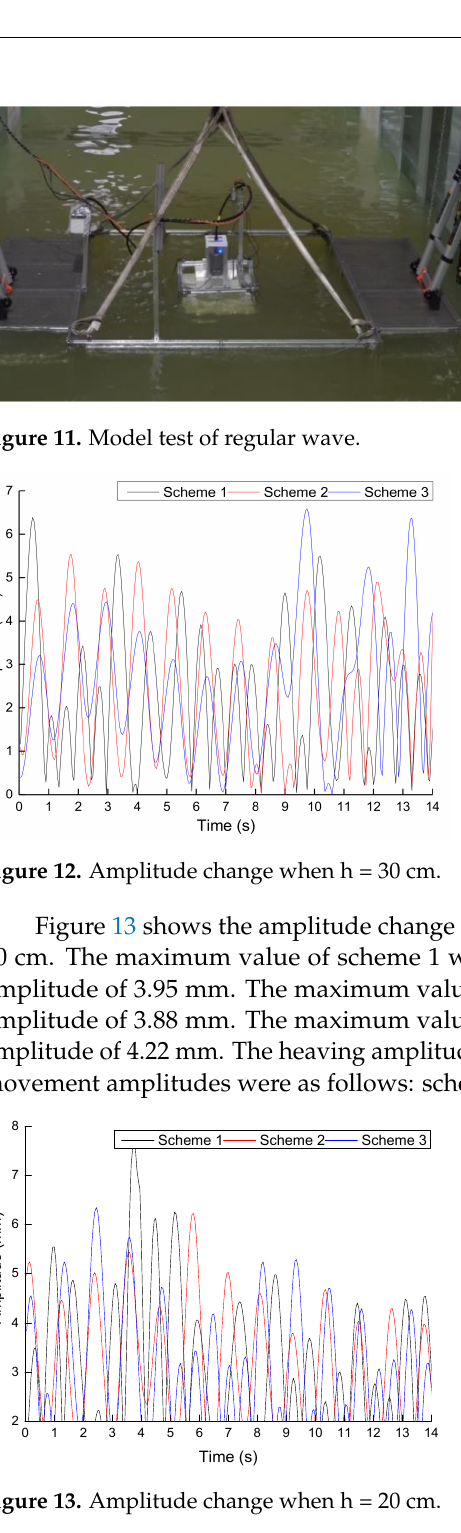
Figure 14. Amplitude change when h = 10 cm. 0 1 2 3 4 5 6 7 8 9 10 11 12 13 148 91011121314 1516 1718 A m p li t ude ( mm ) Time (s) Scheme 1 Scheme 3 Scheme 4 Figure 15. Amplitude change when h =5 cm and no heaving plate is installed. Figure 16 shows the change in the average amplitude of the heaving plate as the in- stallation distance changes. The average amplitudes of the three different shapes of heav- ing plates decreased with an increasing installation distance. When the distance was be- tween 10 mm and 20 mm, the average amplitude changed significantly, and when the distance was between 20 mm and 30 mm, the average amplitude changed relatively little. Therefore, the installation distance under this regular wave condition should be more than 20 mm. When the areas were the same, the average amplitude of the circular heaving plate was greater than that of the square heaving plate and chamber heaving plate.